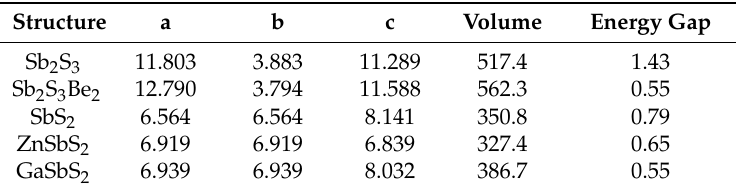
Table 1. Calculated structural parameters (Å), volume (Å 3 ), and energy band gap (eV) of Sb 2 S 3 , SbS 2 , and their